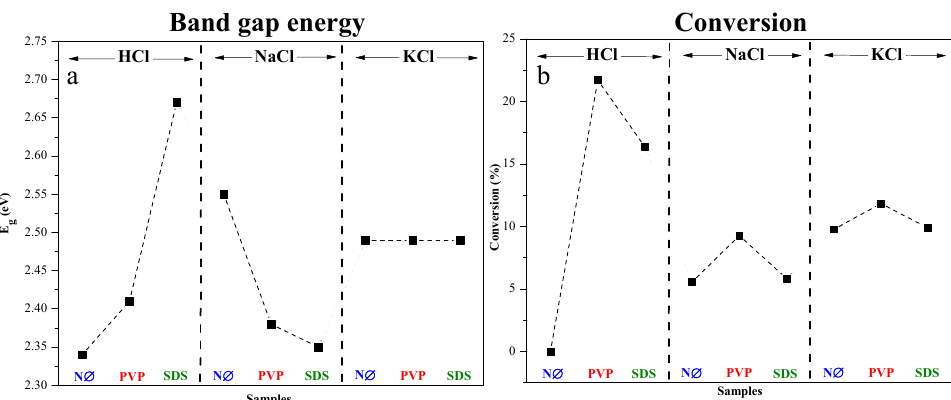
Figure 3. ( a ) Band gap energy values and ( b ) photocatalytic performance of AgCl photocatalysts.